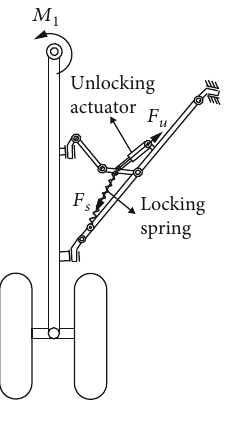
Figure 7: Load analysis at the singular position of landing